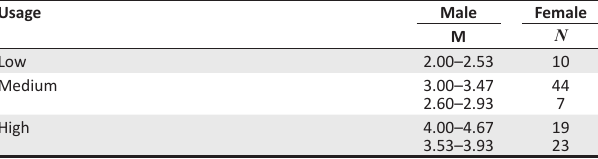
TABLE 1A: Overall strategy usage on the SORS for Botswana students.